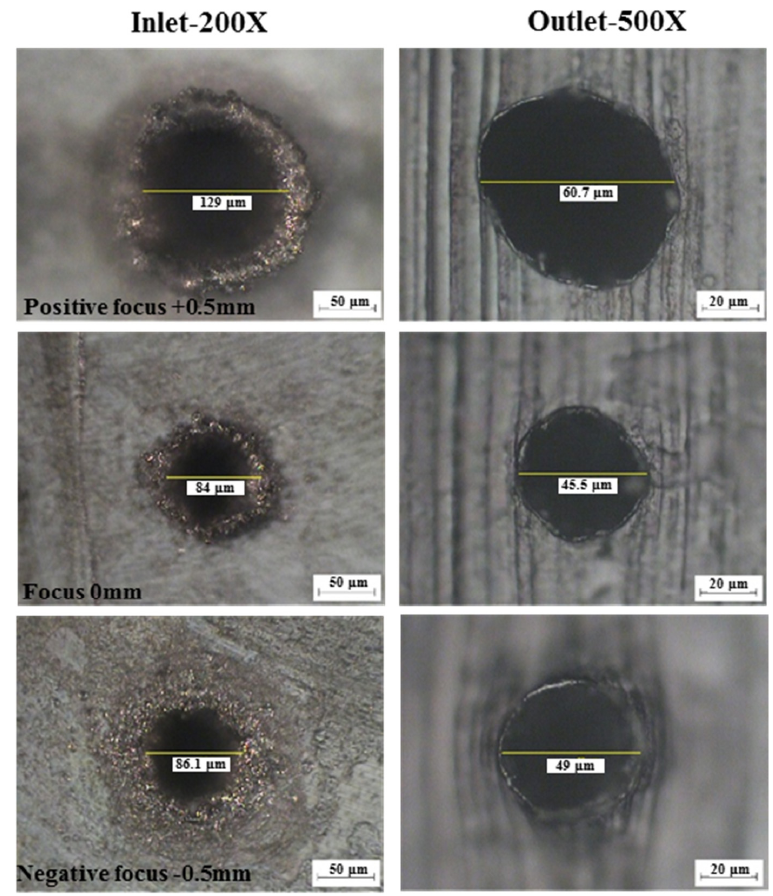
Figure 13. OM images of laser processed holes.